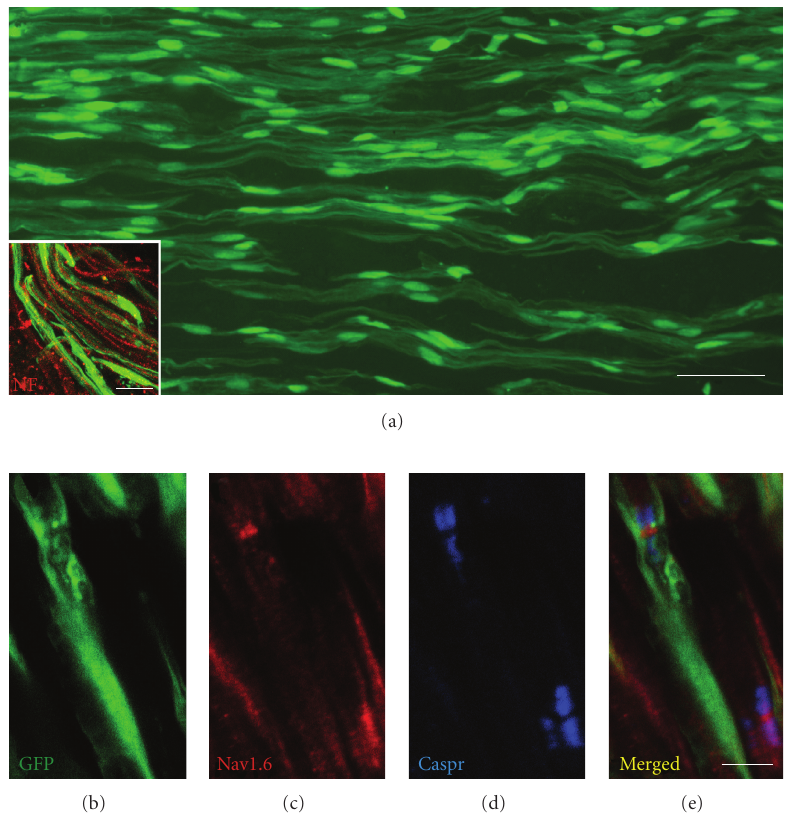
Figure 4: OECs transplanted into injured peripheral nerve remyelinate regenerating axons. (a) GFP can be seen in the nuclei and cytoplasm around regenerating peripheral nerve axons. The inset indicates that the GFP elements are longitudinally oriented with neurofilament- (NF-) stained regenerated axons. (b–e) Longitudinal section of a group of regenerated axons with GFP cells (b) surrounding the axons and sodium channel Nav1.6 (c) being flanked by the Caspr immunostained paranodes (d) indicating that the transplanted OECs can remyelinate regenerated axons which form appropriate sodium channels at the newly formed nodes of Ranvier (overlay in (e)). Scale bars: (a) = 50 µ m (a), (b–e), and (a) inset in (a) = 5 µ